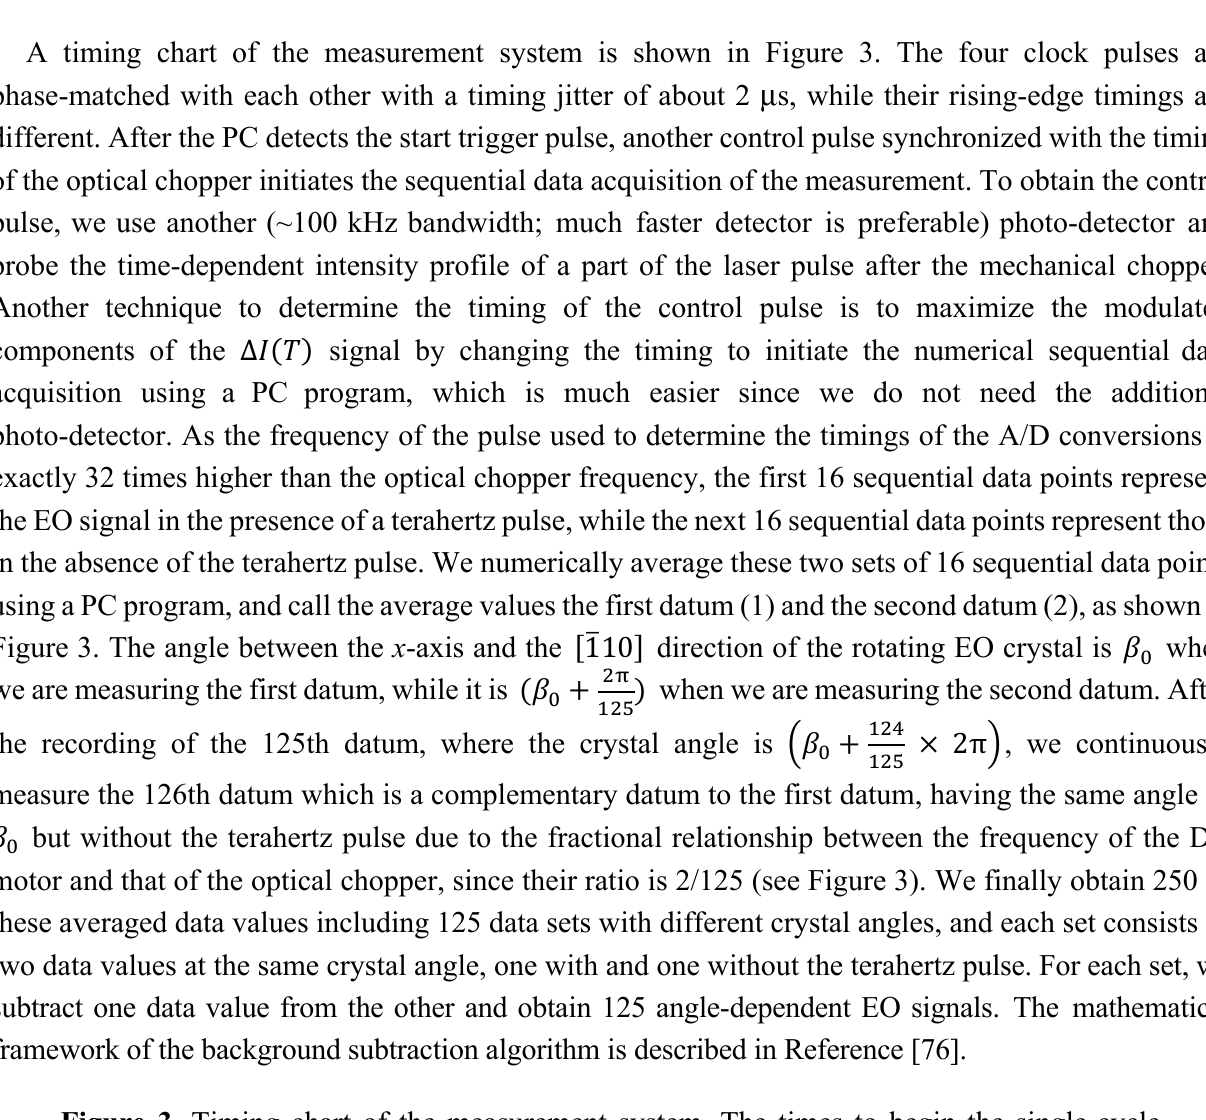
Figure 3. Timing chart of the measurement system. The times to begin the single-cycle measurements are indicated by the two dotted lines. In practice, one of the two dotted lines cannot be used to start the measurement, because one needs additional time for the numerical computations. Four clock pulses are matched in phase with each other with a timing jitter of about 2 μ s, while their rising-edge timings are different. The frequency of each electronic pulse is also